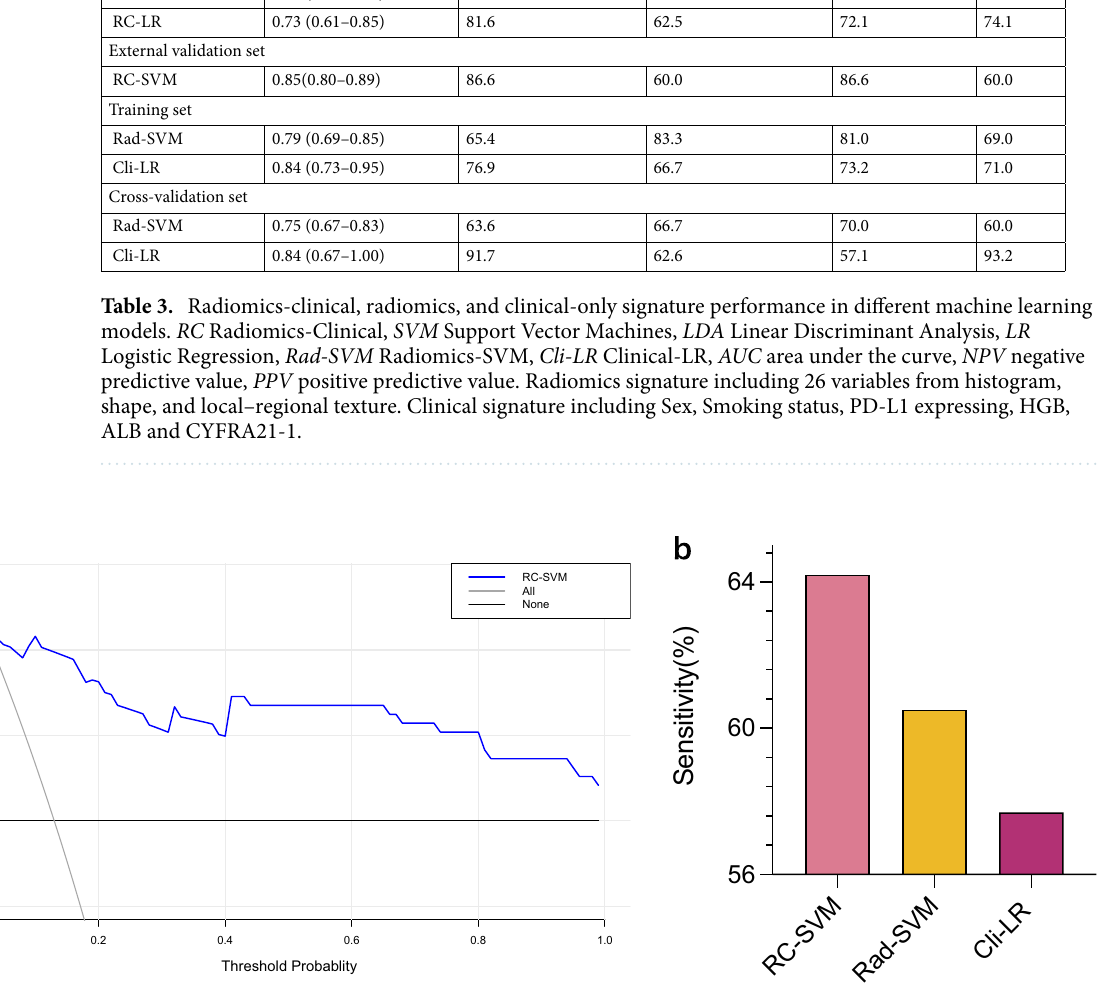
Figure 4. Clinical usefulness of radiomics-clinical SVM. RC Radiomics-Clinical, SVM Support Vector Machines, LDA Linear Discriminant Analysis, LR Logistic Regression, Rad-SVM Radiomics-SVM, Cli-LR Clinical-LR. ( a ) Decision curve analysis of RC-SVM, with a threshold range of about 0.12–0.98 and a maximum net benefit of about 0.13. ( b ) Sensitivity at 95% specificity for the RC-SVM, Rad-SVM and Cli-LR (64.2%, 60.5% and